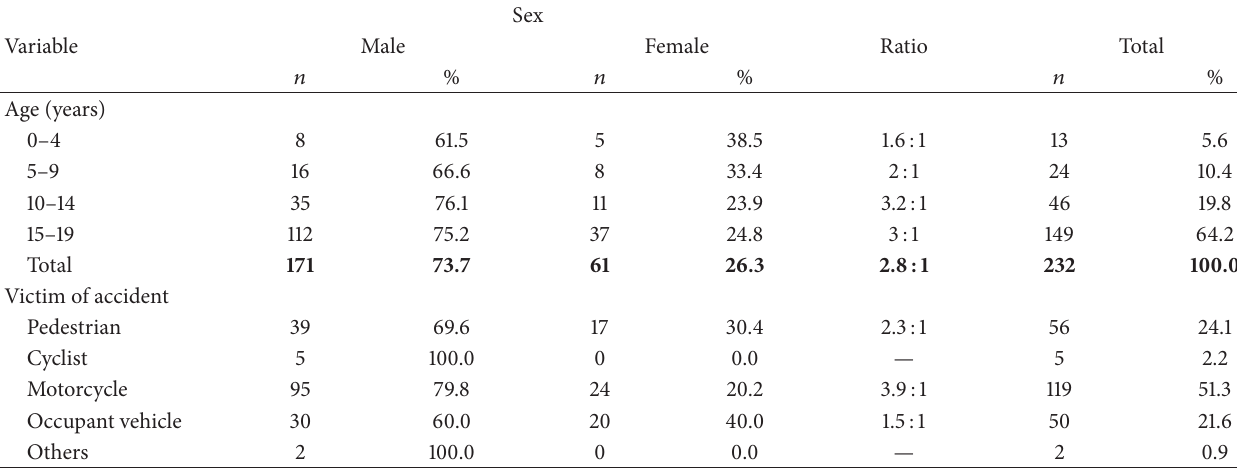
Table 1: Sample distribution according to age, type of accident, and sex in Campina Grande, Brazil.